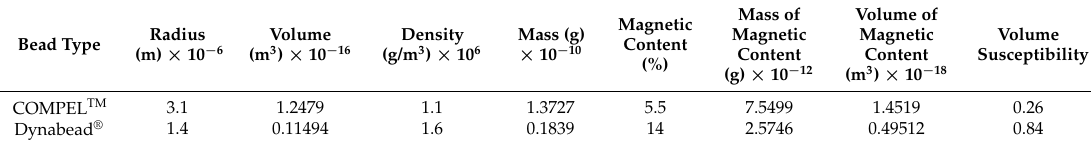
Table 1. Superparamagnetic bead characteristics